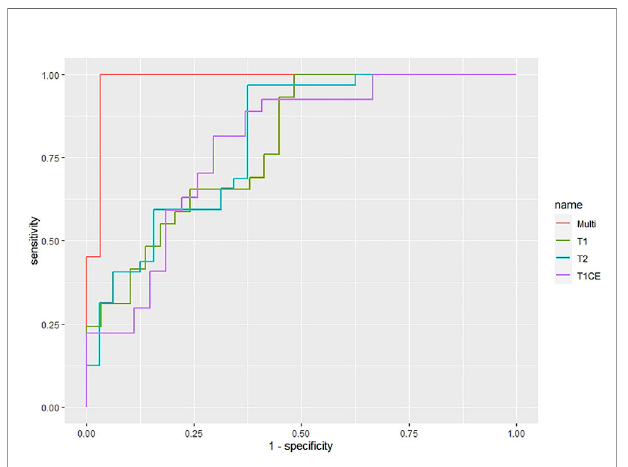
FIGURE 4 | The ROC curves of the four imaging prediction models whereby the green curve represents the T1WI model, the blue curve represents the T2WI, the purple curve represents T1CE, and the red curve represents the multiparametric MRI model.